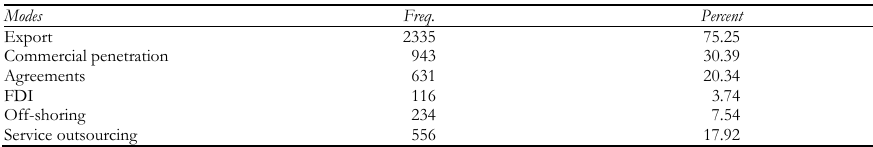
Marginal distribution of internationalization modes